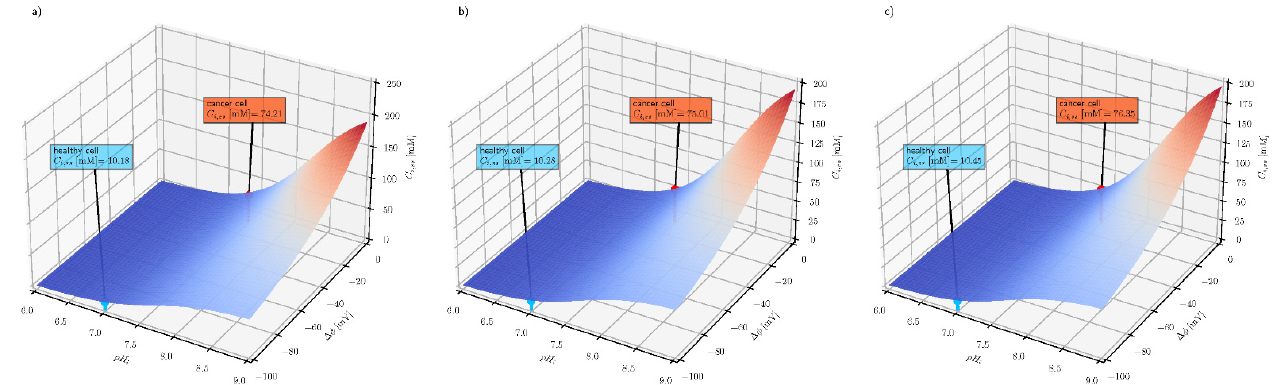
Figure 4. The effect of intracellular pH (pH e = 7.4) and plasma membrane electrical potential difference on the steady-state intracellular ascorbate concentration for three extracellular ascorbate concentrations ( a ) C e = 0.2 mM ( b ) C e = 0.5 mM ( c ) C e = 1 mM for cancer (red label) and health cells (blue label), respectively.